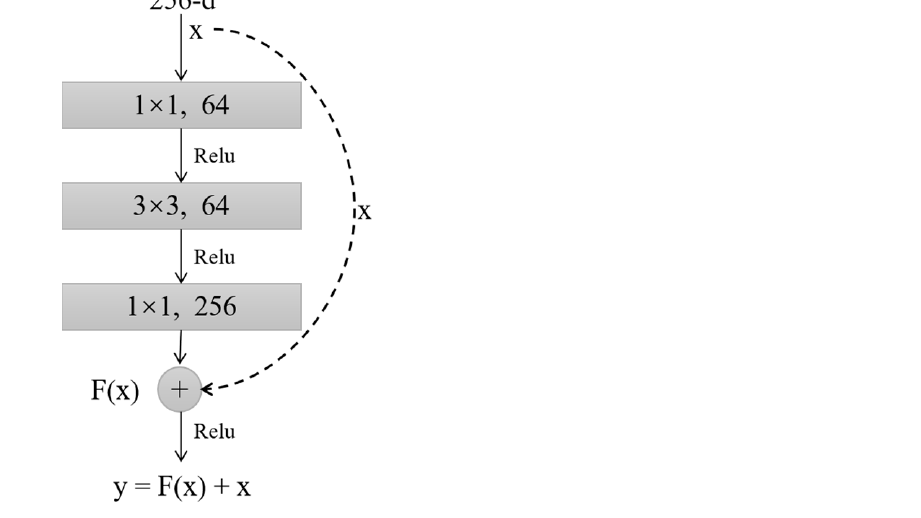
Figure 2. A “Bottleneck” building block for ResNet-50, where the 1 × 1 layers are responsible for reducing and then increasing (restoring) dimensions, leaving the 3 × 3 layer with a bottleneck of smaller input/output dimensions.